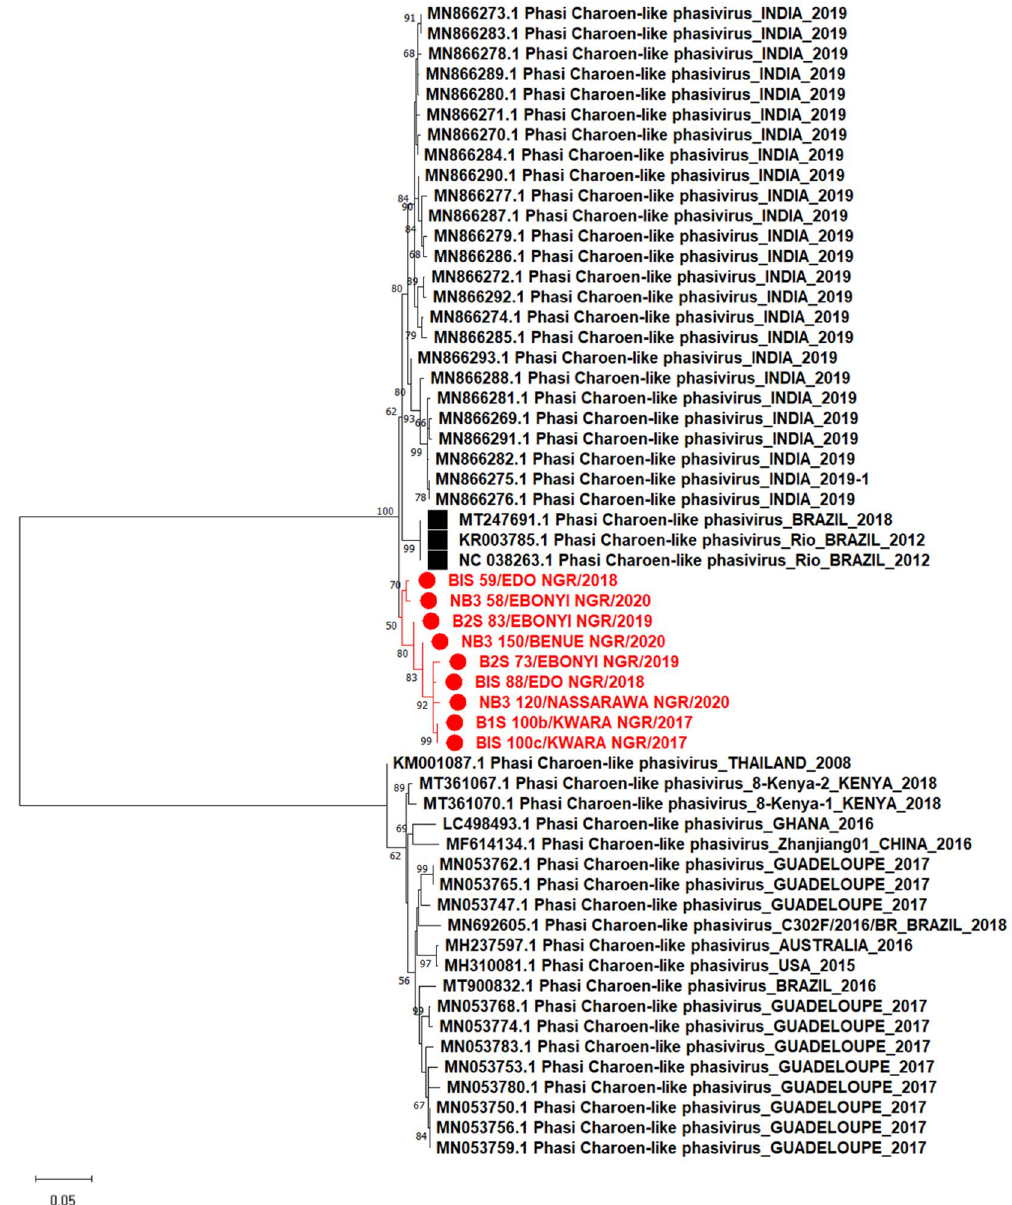
Figure 5. Maximum likelihood phylogenetic tree showing evolutionary relationship between the S segment (Nucleocapsid) of Phasi Charoen like phasivirus sequences from this study and those obtained from the NCBI database. The evolutionary history was inferred by using the Maximum Likelihood method and Tamura-Nei model with 1000 bootstrap replicates. The numbers at branch nodes indicate the bootstrap values ≥ 50%.